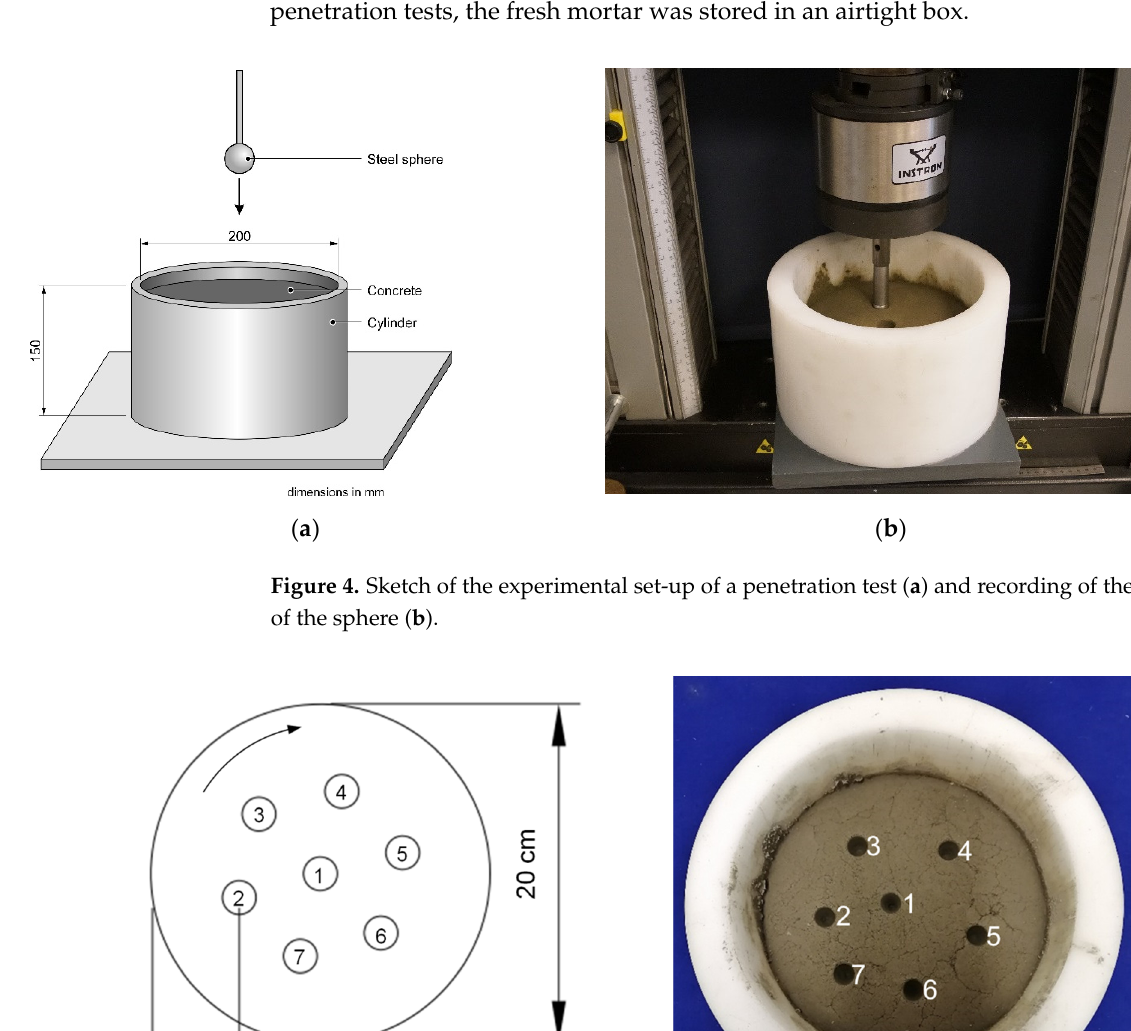
Figure 6. Sketch and dimensioning of the capillary rheometer test set-up based on [8]. The upper cylinder has an inner diameter of 70 mm and a height of 205 mm. The inner diameter of the upper cylinder was chosen based on the geometry of the extruder’s main screw. The lower cylinder has an inner diameter of 27.6 mm and a height of 67.0 mm. The resulting cylinder opening has a cross-sectional area of around 600 mm 2 and